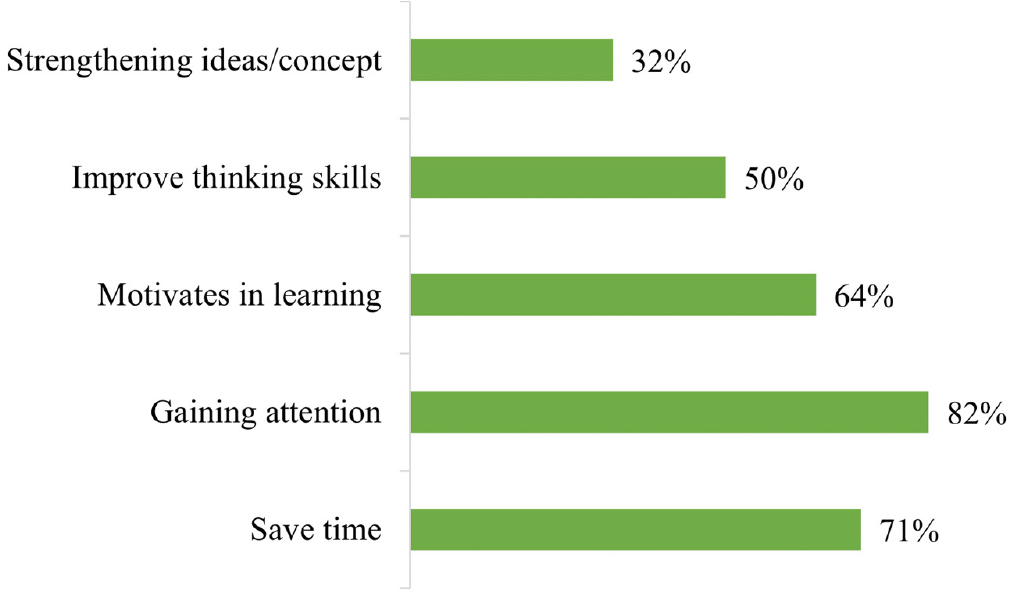
Figure 9. Bene fi ts of using the H5P tool according to students.